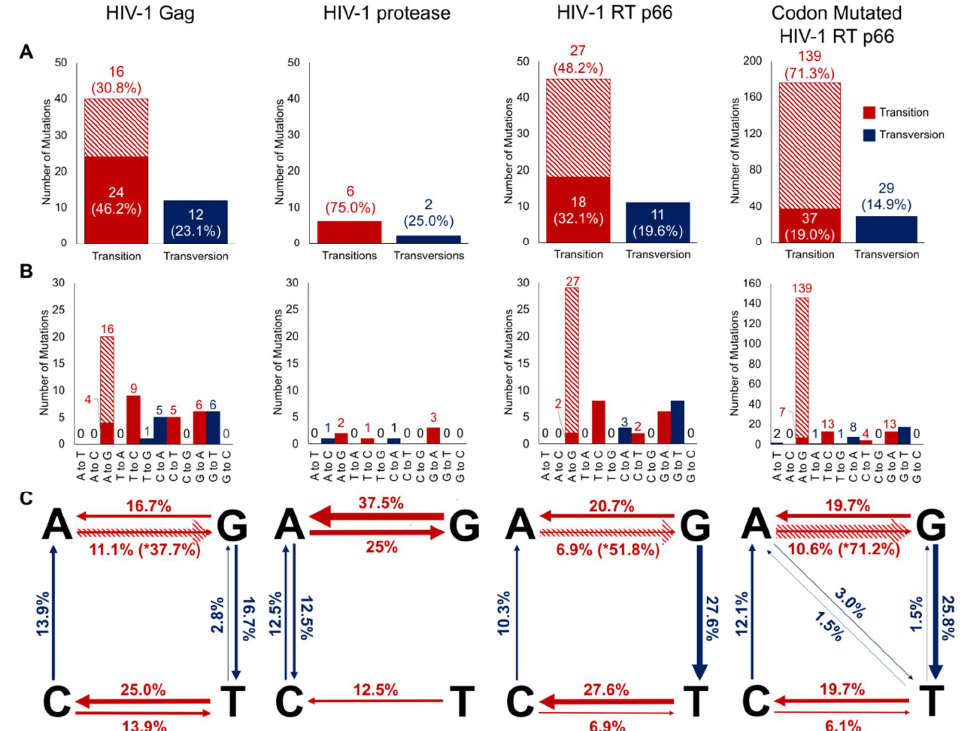
Figure 2. Generated HIV-1 Gag, protease, RT p66, and Codon Mutated RT p66 nucleotide substitution mutations using HIV-1 RT. ( A ) Bar chart of transitions and transversions mutations observed in HIV-1 Gag ( n = 52), protease ( n = 8), RT p66 ( n = 56) and codon mutated p66 ( n = 205). Transitions and transversions are shown in red and blue, respectively. ‘A to G’ hypermutations are shown separately as diagonal stripes. ( B ) Bar chart of substitution mutations observed in HIV-1 Gag, protease, RT p66, and codon mutated p66 sequences. ( C ) Schematic diagram of relative nucleotide substitution frequencies on the respective HIV-1 genes (expressed as a percentage).